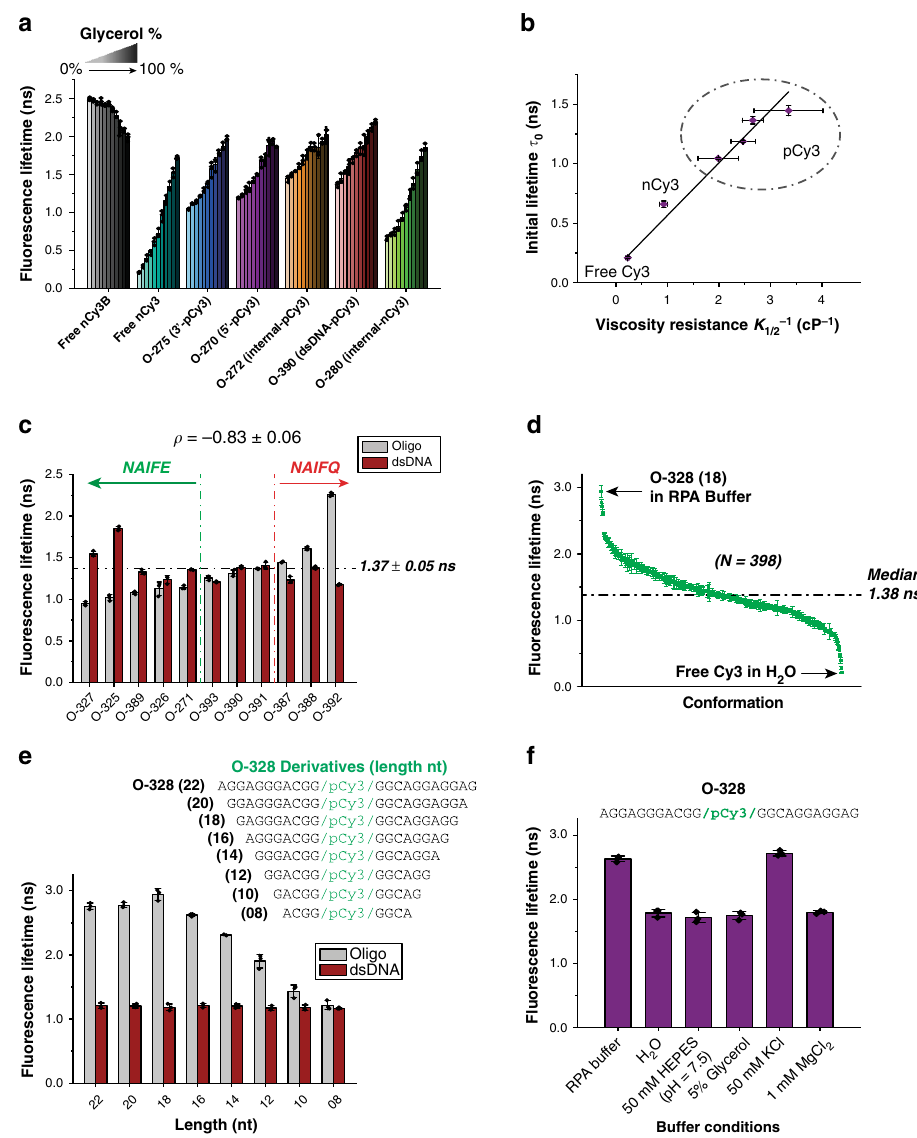
Fig. 4 Insights into the structural properties of the DNA – Dye complexes. a Effect of viscosity on fl uorescence; bar charts represent the fl uorescence lifetimes of different fl uorophores (free or DNA – Dye complexes), at increasing concentrations of glycerol (0 – 100%), in 10% increments. b Dependence of the fl uorescence lifetime, without glycerol, on the viscosity resistance. The plot shows a linear dependence with slope of 0.44 ± 0.02 ns cP and y-intercept of 0.13 ± 0.04 ns. The horizontal error bars represent the standard error of the mean. The goodness of the linear fi t, R 2 value, is 0.989. c Fluorescence lifetimes of 11 internal-pCy3-labeled oligo library with different sequences (gray) and their corresponding dsDNA (red). The horizontal dashed line shows the average fl uorescence lifetime of dsDNA in this library. The green vertical dashed line delimits oligos that show an overall NAIFE effect, upon annealing of their complementary strand, whereas the red vertical dashed line delimits those showing an overall NAIFQ effect. The Pearson coef fi cient of the correlation between the initial fl uorescence lifetime (ssDNA) and the fl uorescence change (%), upon annealing the complementary oligo, is reported with its respective standard error. d Fluorescence lifetime landscape of Cy3 compiling all the Cy3 lifetimes measured in this study ( N = 398). The horizontal dashed line represents the median value of the landscape. e Bar chart indicating the fl uorescence lifetime of O-328 and its derivatives, in ssDNA (gray) and dsDNA (black) forms, measured in RPA buffer. f Bar chart indicating the fl uorescence lifetime of O-328 in ssDNA form, in different individual RPA buffer components. Error bars represent SD from three replicates and ± represent SEM. Oligo sequences are listed in Supplementary Table